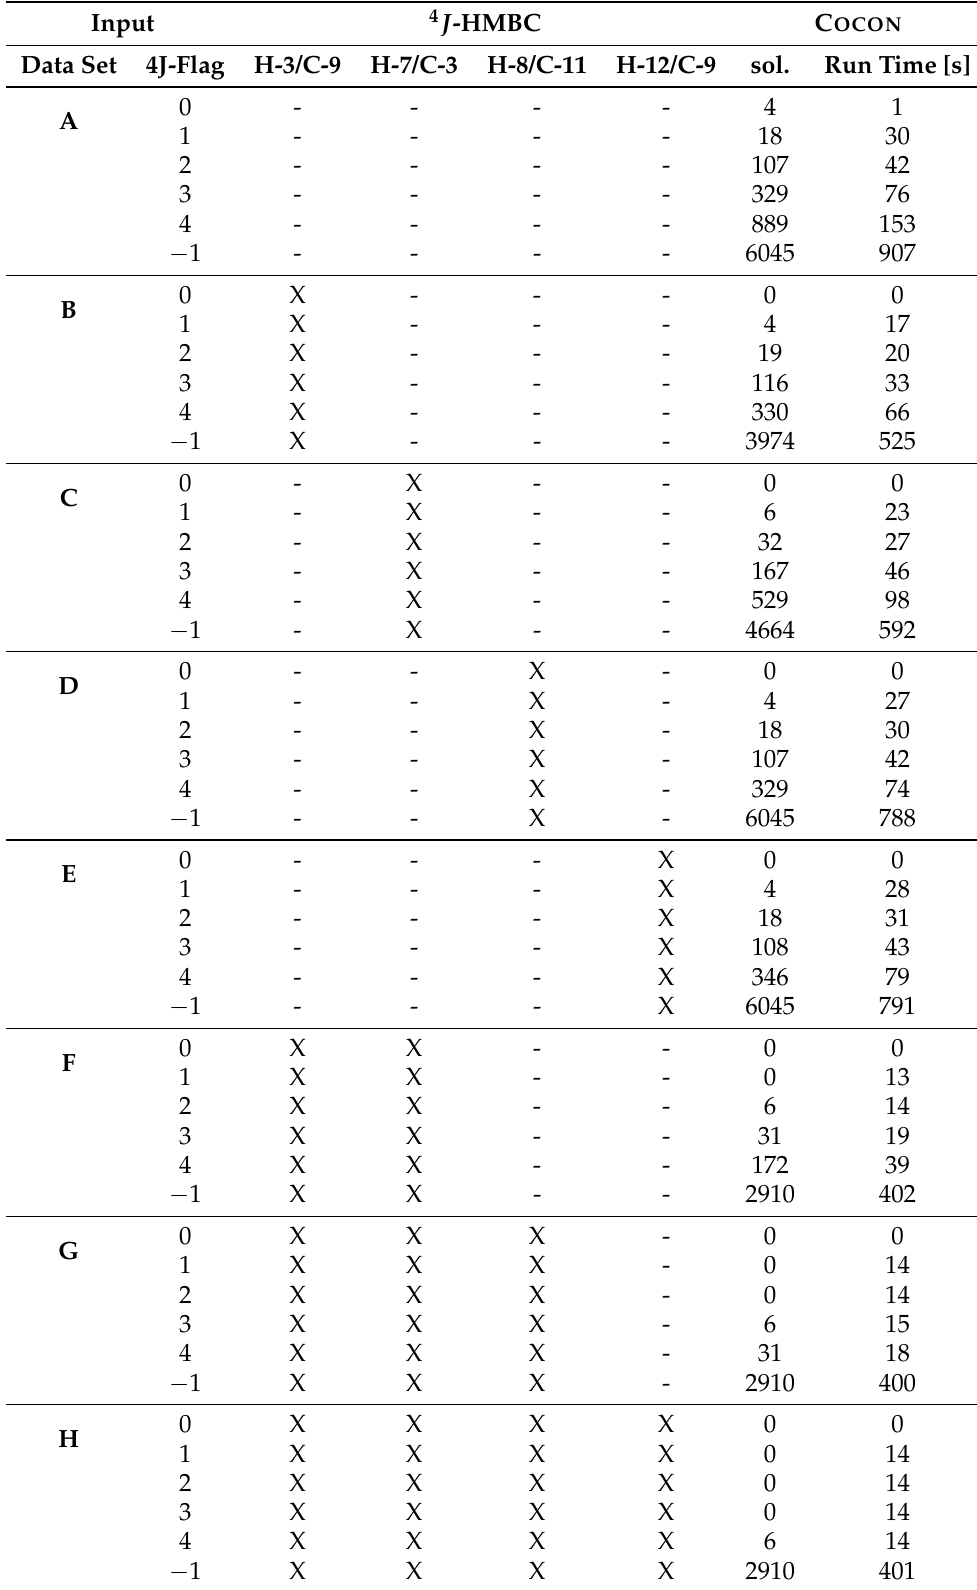
Table 3. Number of solutions generated by W EB C OCON , depending on the 4 J correlations included in the data set, number of allowed 4 J correlations in structure generation, and computer time used (averaged over three runs, on an Intel Core i7-3770 processor